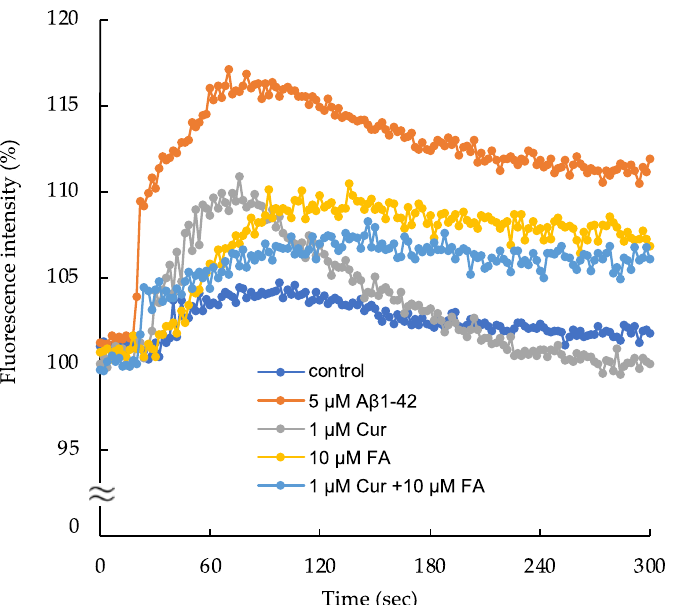
Figure 9. Detection of changes in intracellular ionized calcium concentration ([Ca 2+ ] i ) in SH-SY5Y cells.